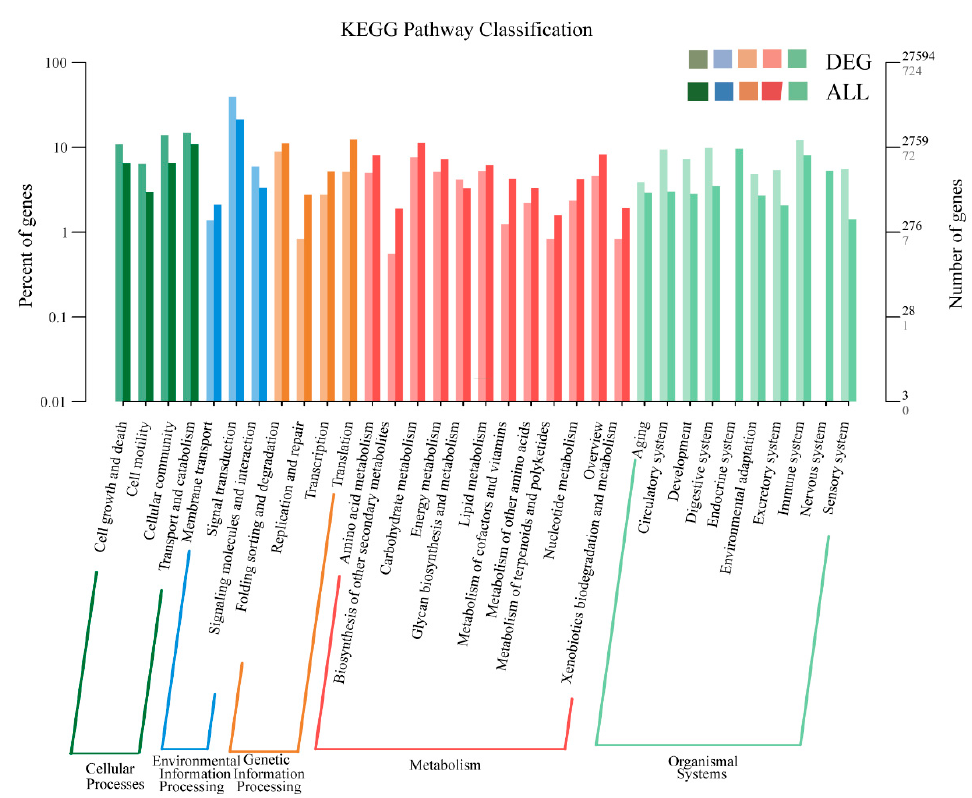
Figure 5. KEGG functional classification of differentially expressed genes (DEGs) in FW leeches and SW leeches.